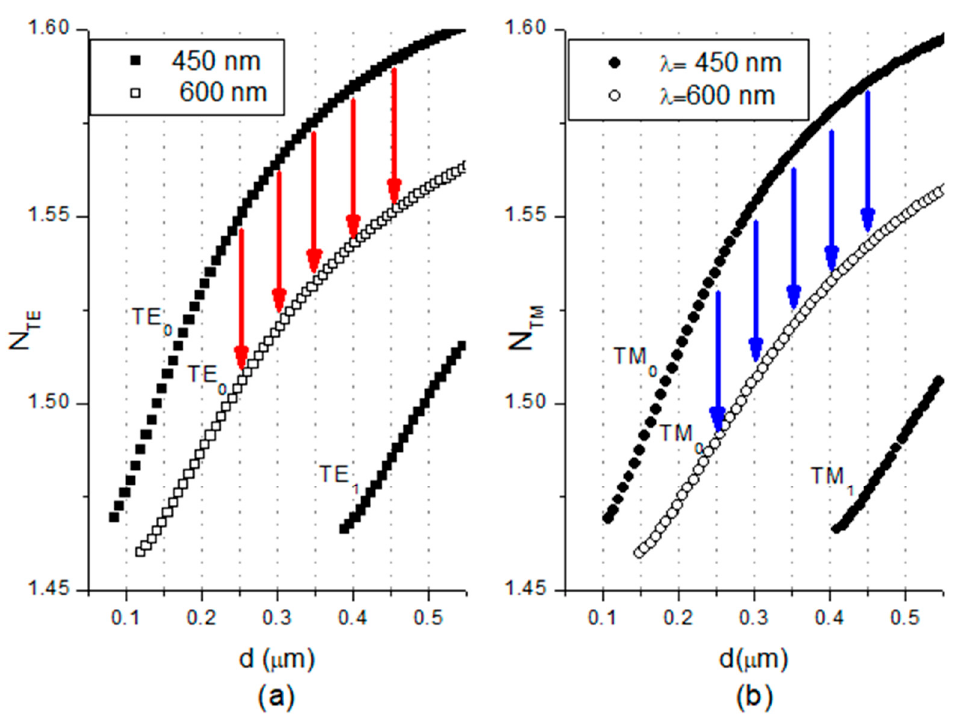
Figure 4. E ff ective refractive indices ( a ) TE polarization and ( b ) TM polarization as a function of the waveguide layer thickness d at 450 and 600